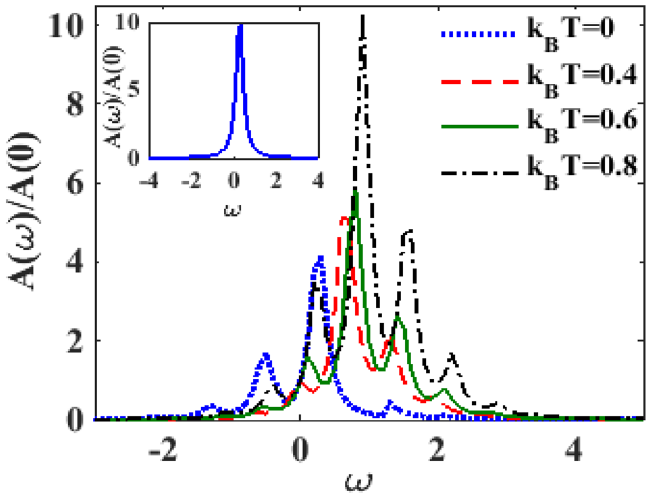
Figure 2. A (ω)/ A ( 0 ) as a function of ω for different values of k B T at (cid:31) = 0.6, γ = 0.02, eV b = 2.5, eV m = 0.5